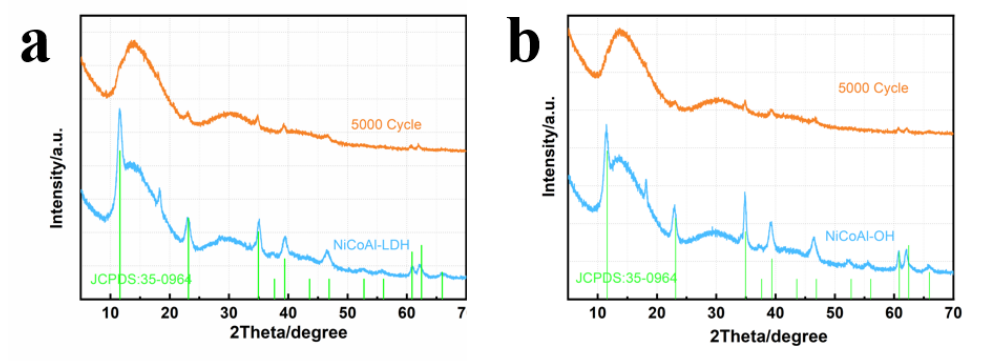
Figure 5. XRD patterns of electrodes of ( a ) NiCoAl-LDH before and after 5000 cycles, and ( b ) NiCoAl-OH before and after 5000 cycles.